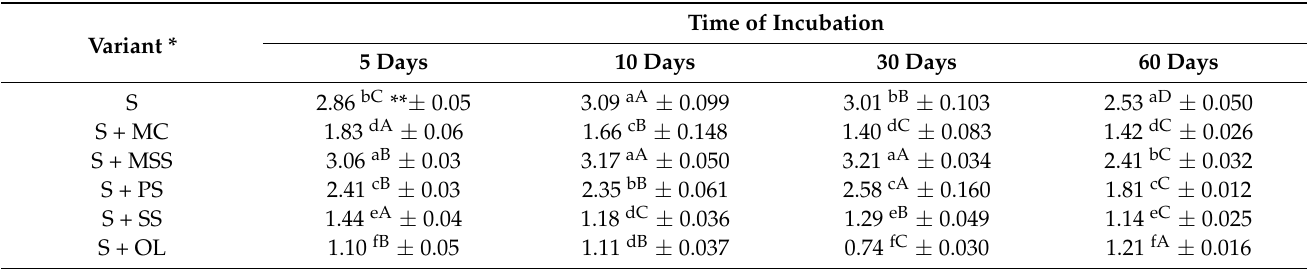
Table 7. The activity of acid phosphatase AcP (mMpNP kg − 1 h − 1 ).